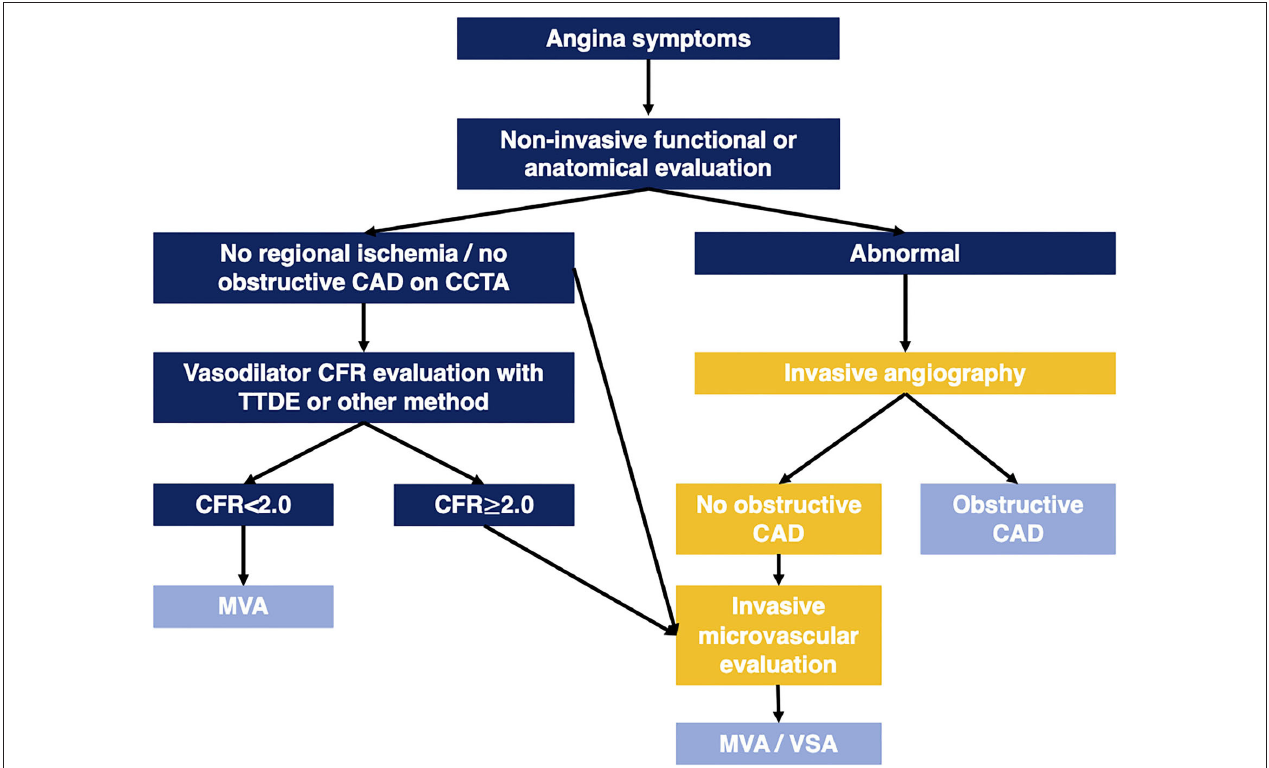
FIGURE 2 | Algorithm illustrating diagnostic work-up in angina patients integrating CMD evaluation. CAD, coronary artery disease; CCTA, coronary computed tomography angiography; CFR, coronary flow reserve; MVA, microvascular angina; TTDE, transthoracic Doppler echocardiography; VSA, vasospastic angina.